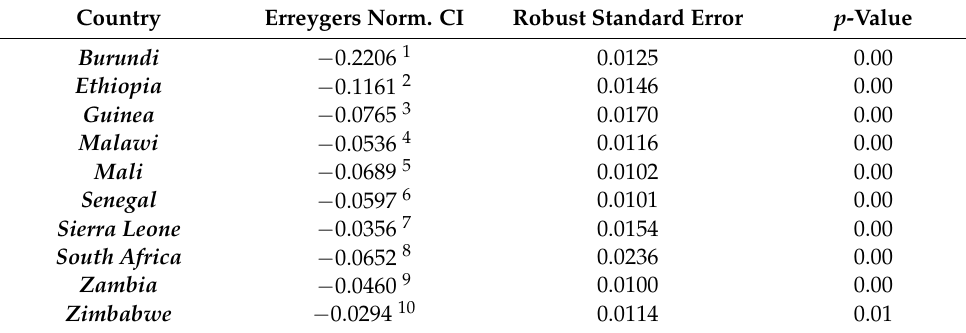
Table 8. Erreygers Normalized Concentration Indices for DBM by country. Country Erreygers Norm. CI Robust Standard Error p -Value Burundi − 0.2206 1 0.0125 0.00 Ethiopia